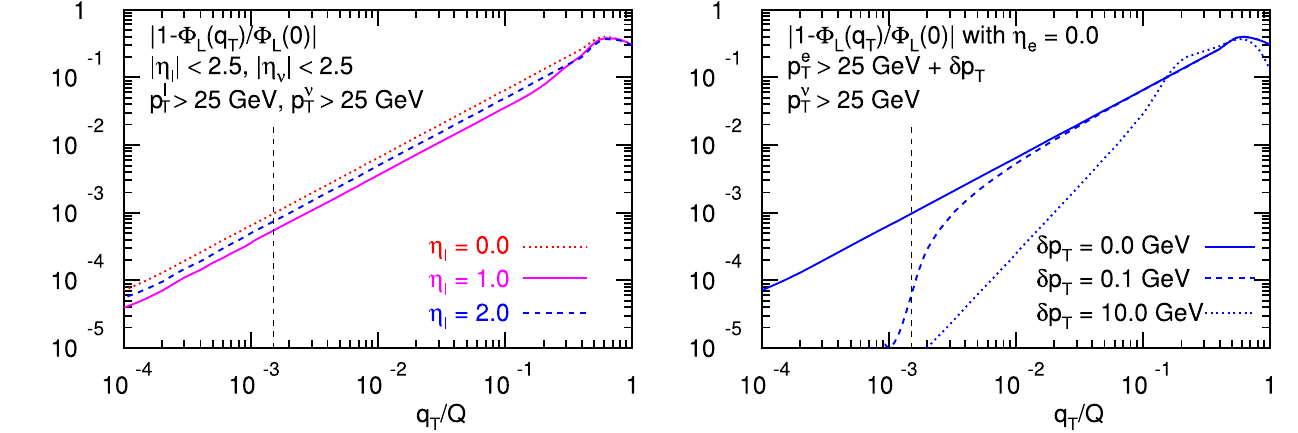
Fig. 17 Same as Fig. 15 for the fiducial cuts applied to the DØ data [8] for the electron charge asymmetry distribution A e , using staggered + δ p ≥ p min ≥ 25 GeV cuts p T 1 ≥ p min and Q = M W for the electron T , p T 2 T T T pseudo-rapidity fixed at η e =